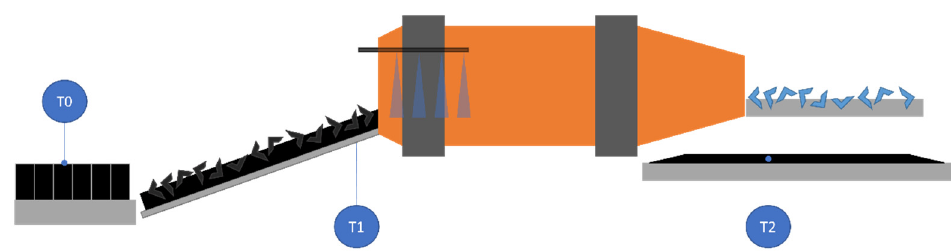
Figure 2. Diagram showing the end of the cooling line with a mold cup temperature sensor (T0), another sensor at the cooling drum inlet to improve temperature adjustment (T1), and a final sensor (T2) installed on the cooling drum outlet tape.